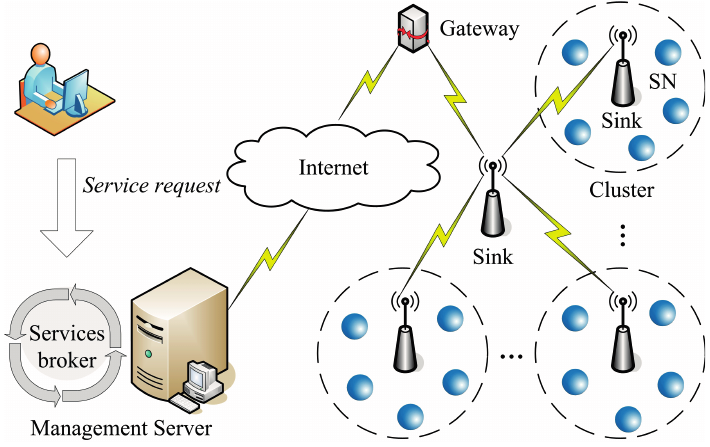
Figure 1. Architecture of a WSN service system.